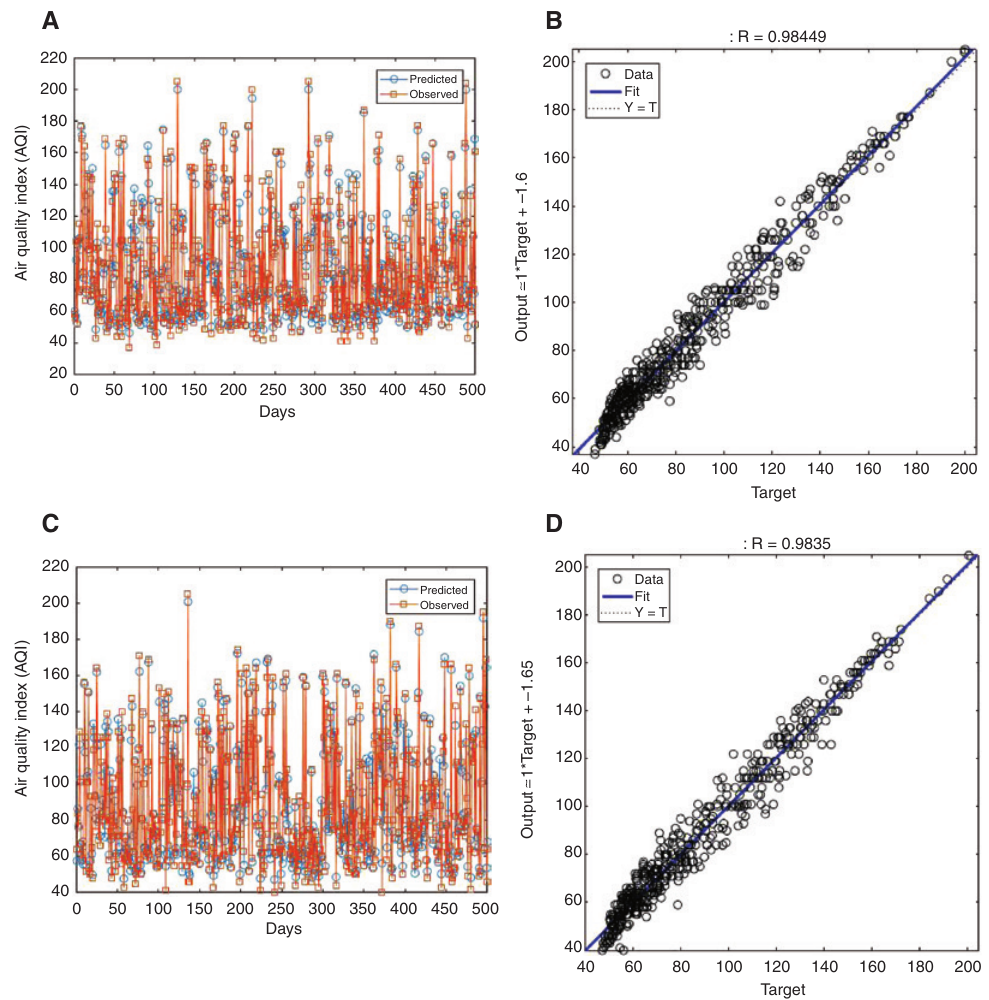
Figure 6: SVR Ensemble of Regression Models: (A) Testing Plot for Houston, (B) Regression Plot for Houston, (C) Testing Plot for Los Angeles, and (D) Regression Plot for Los